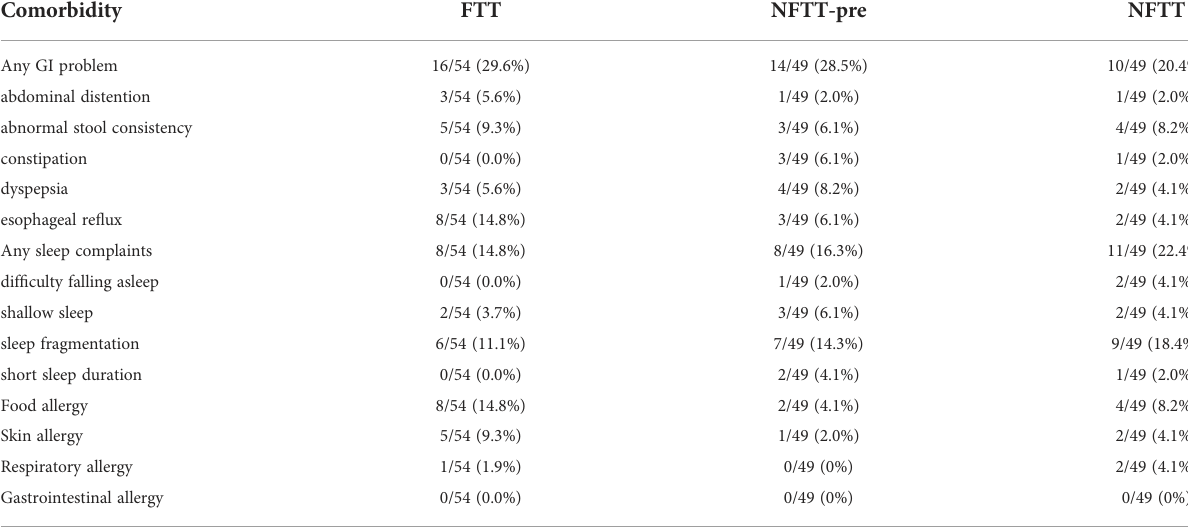
TABLE 1 Distributions of comorbidities among 3 groups. Comorbidity Any GI